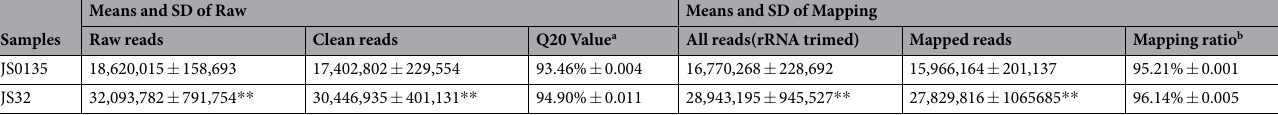
Table 2. Statistical summary of RNA–seq datasets in JS32 and JS0135 . a The sequencing quality values correspond to 0.01 of error chance, b Mapping ratio = Mapped reads/All reads, * represents statistically significant ( p ≤ 0.05), ** represents extremely significant ( p ≤